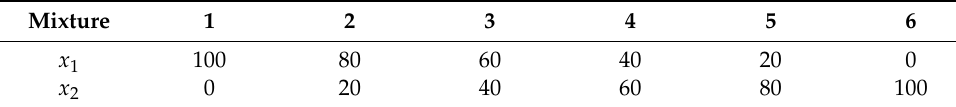
Table 4. Weight fractions x 1 and x 2 for each material blend.